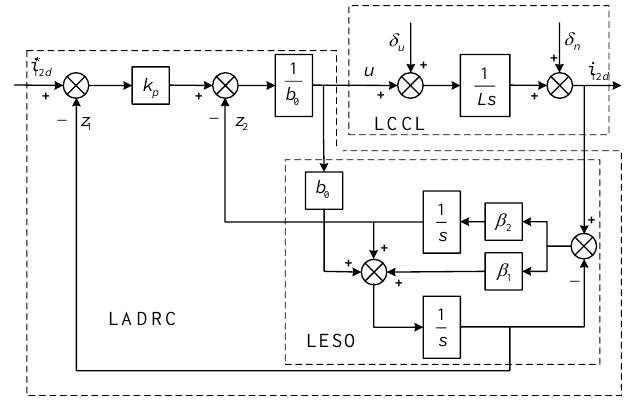
Figure 2. Grid-connected inverter LADRC block diagram.